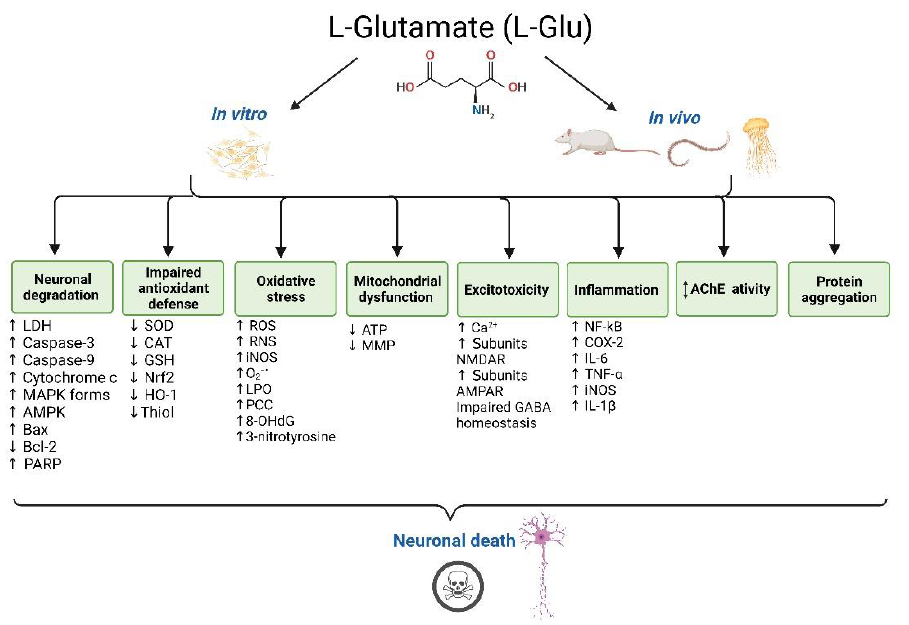
Figure 4. Schematic summary of the shared neurotoxicity mechanisms of L-Glu reported from in vitro and in vivo model studies. Abbreviations: AMPAR, α -amino-3-hydroxy-5-methyl-4-isoxazolepropionic acid receptor; AMPK, 5′ AMP -activated protein kinase; ATP, adenosine diphosphate; Bax, Bcl-2-associated X protein; Bcl-2, B-cell lymphoma-2; Ca 2+ , calcium ion; CAT, catalase; COX-2, cyclooxygenase-2; GABA, gamma-aminobutyric acid; GSH, glutathione; HO-1, heme oxygenase-1; IL- 1β, interleukin 1 beta; IL-6, interleukin 6; iNOS, nitric oxide synthase; LDH, lactate dehydrogenase; LPO, lipid peroxidation; MAPK, mitogen-activated protein kinase; MMP, mitochondrial membrane potential; NF- κB , nuclear factor kappa -light-chain-enhancer of activated B cells; NMDAR, N-methyl-D-aspartate receptor; Nrf2, nuclear factor erythroid 2-related factor 2; O 2- • , superoxide; 8-OHdG, 8-hydroxy- 2′ -deoxyguanosine; PARP, poly (adenosine diphosphate (ADP)-ribose) polymerase; PCC, protein carbonyl content; RNS, reactive nitrogen species; ROS, reactive oxygen species; SOD, superoxide dismutase; TNF- α, tumour necrosis factor - α.